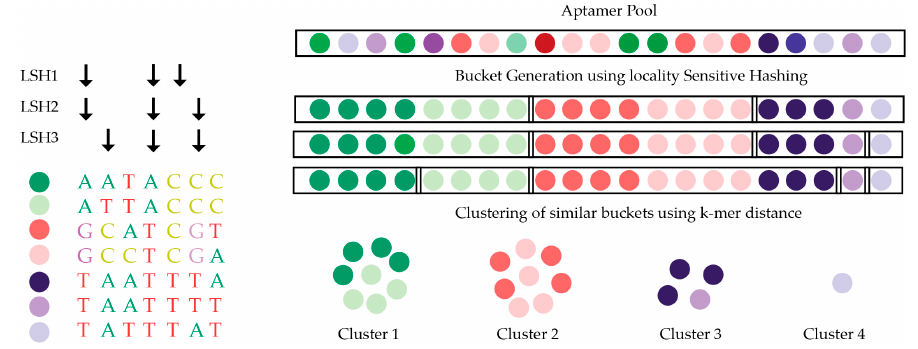
Figure 5. Illustration of the AptaCluster algorithm. Each colored sphere represents an individual sequence in the library and the similar colors represent related sequence. AptaCluster clusters the library pool into different sets of similar sequences based on locality sensitive hashing (LSH). The black arrows represent the user-defined number of nucleotide positions, which are sampled to generate input for the hash function. Figure adapted from Honika [16].